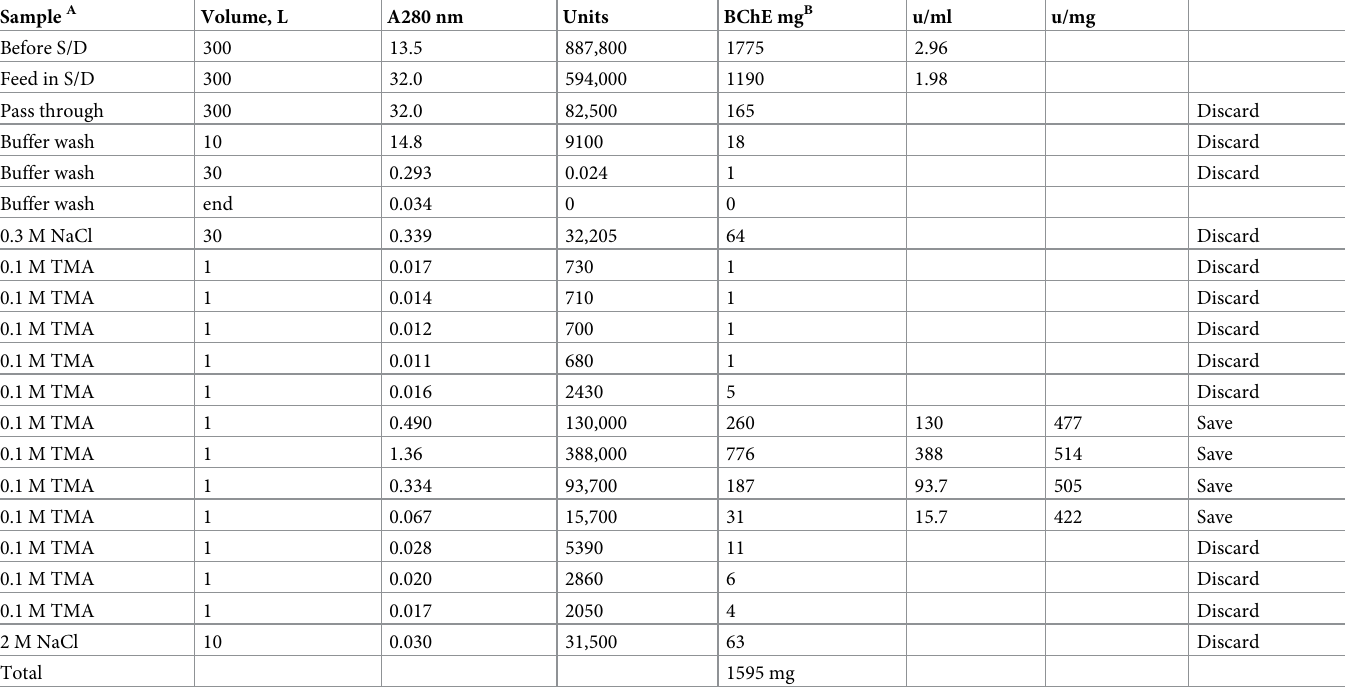
Table 1. Solvent/detergent treated Cohn extract on 4.2 L